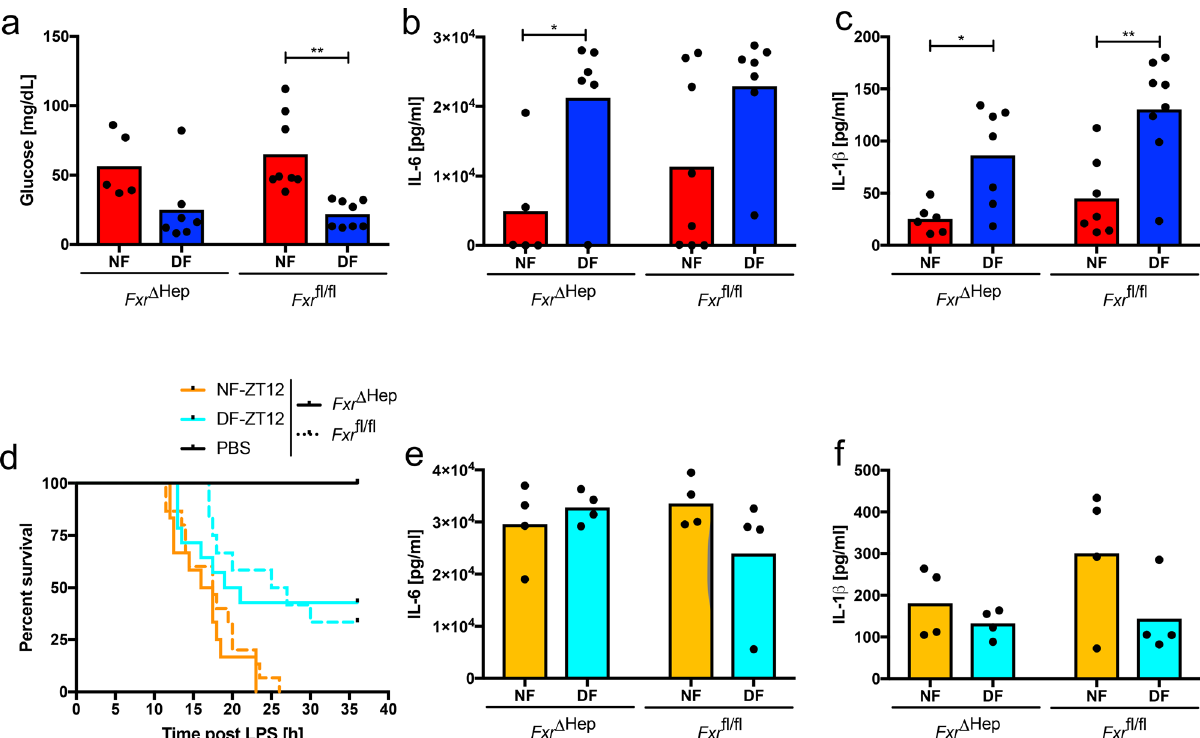
Fig. 7 Feeding-related glucose metabolism and cytokine response are unaffected in Fxr Δ Hep animals. a Serum glucose 6h post 20mg/kg LPS i.p. at ZT0 on day 5 of TRF in Fxr Δ Hep and Fxr fl / fl control female mice. Statistical analysis using two-way ANOVA and Sidak ’ s multiple comparison (NF vs. DF) as indicated. Interaction F (1,24) = 0.4606, p = 0.5038, genotype F (1,24) = 0.09389, p = 0.7619, feeding F (1,24) = 18.28, p = 0.0003. ** p = 0.0017. Fxr Δ Hep